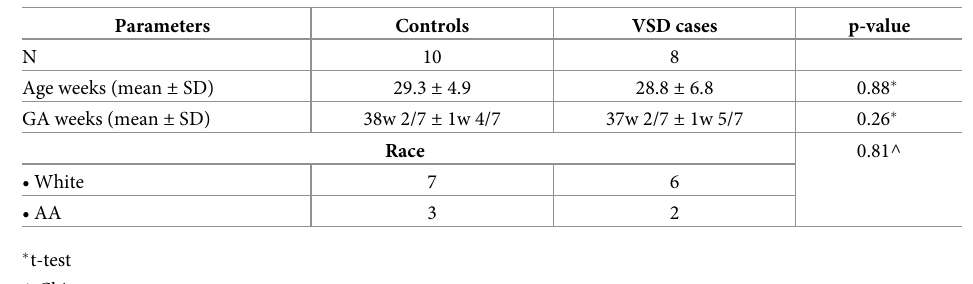
Table 1. Demographics of VSD cases versus